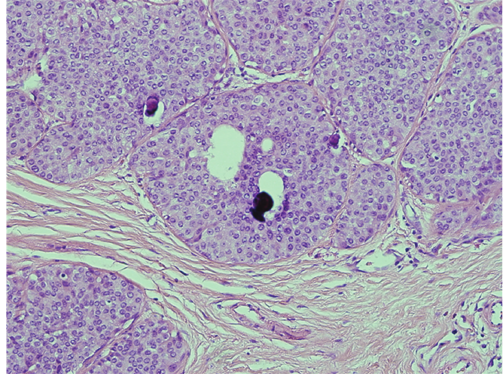
Figure 2: Right breast ductal carcinoma in situ.